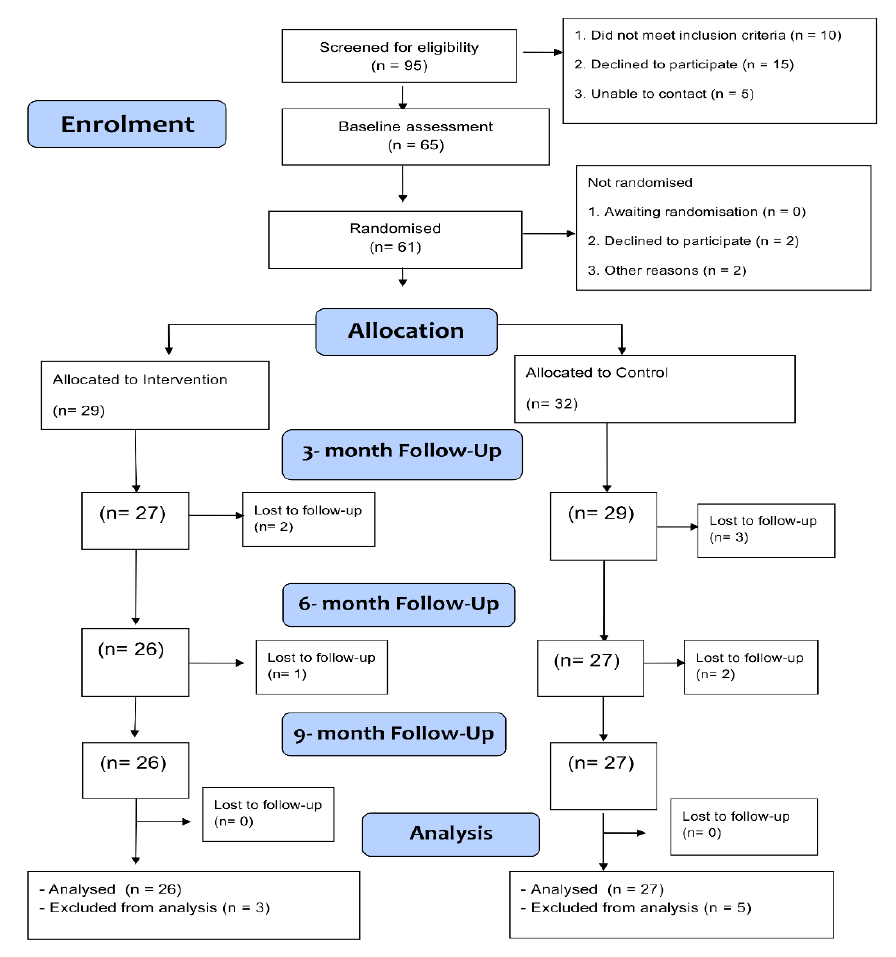
Figure 1. Consort Diagram. Table 1. Baseline characteristics by treatment group. Continuous variables are summarized as mean (SD) and categorical variables are summarised as n